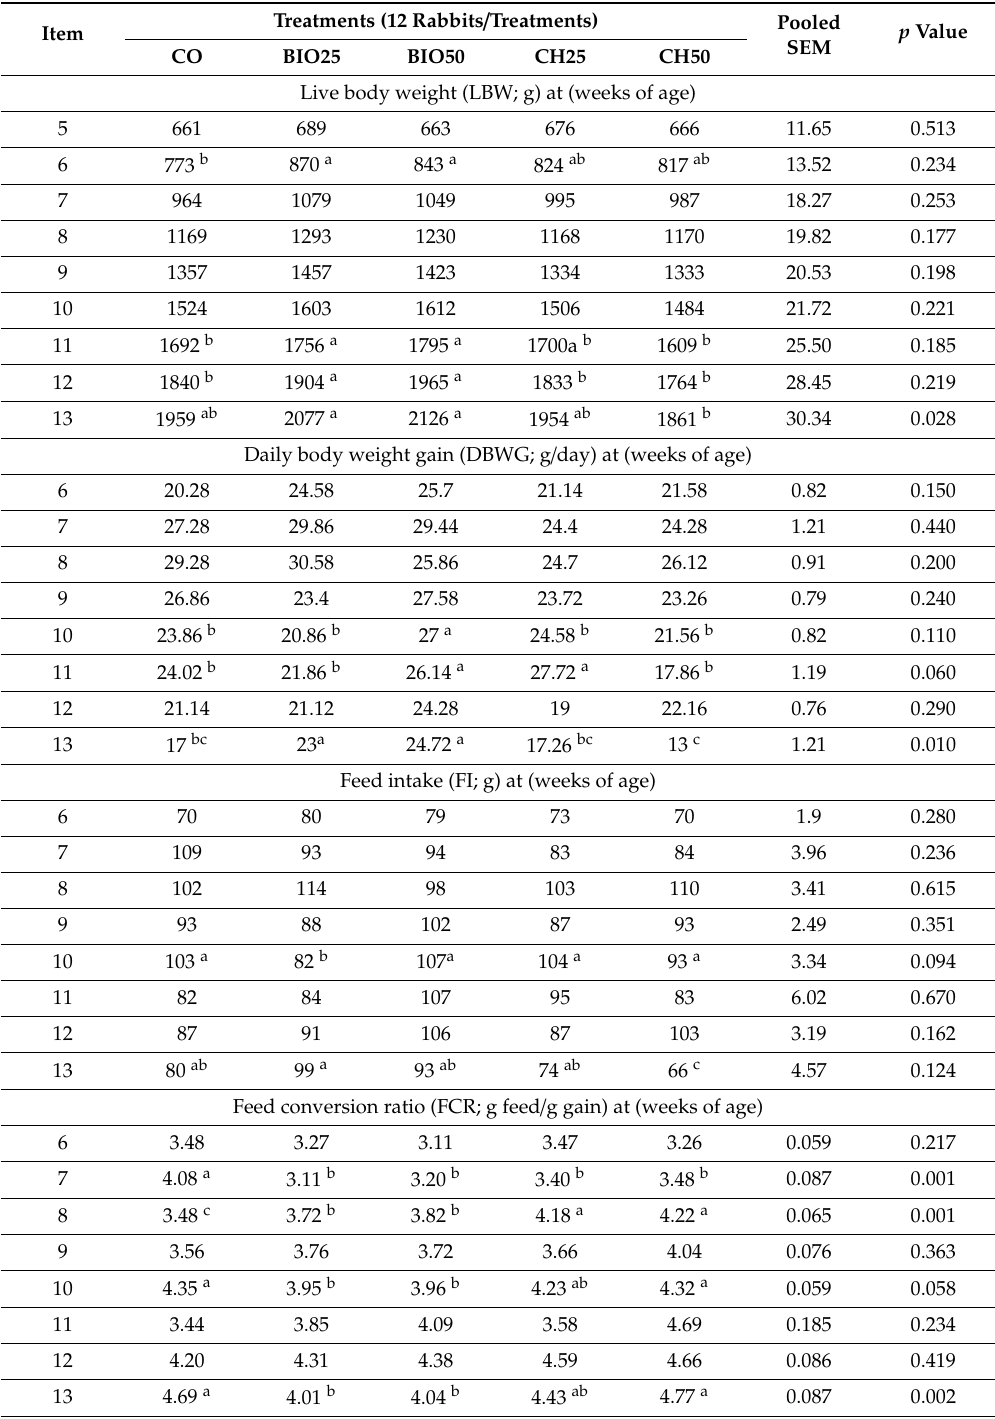
Table 3. Growth performance of growing New Zealand (NWZ) rabbits fed diets supplemented with biological or chemical selenium nanoparticles during heat